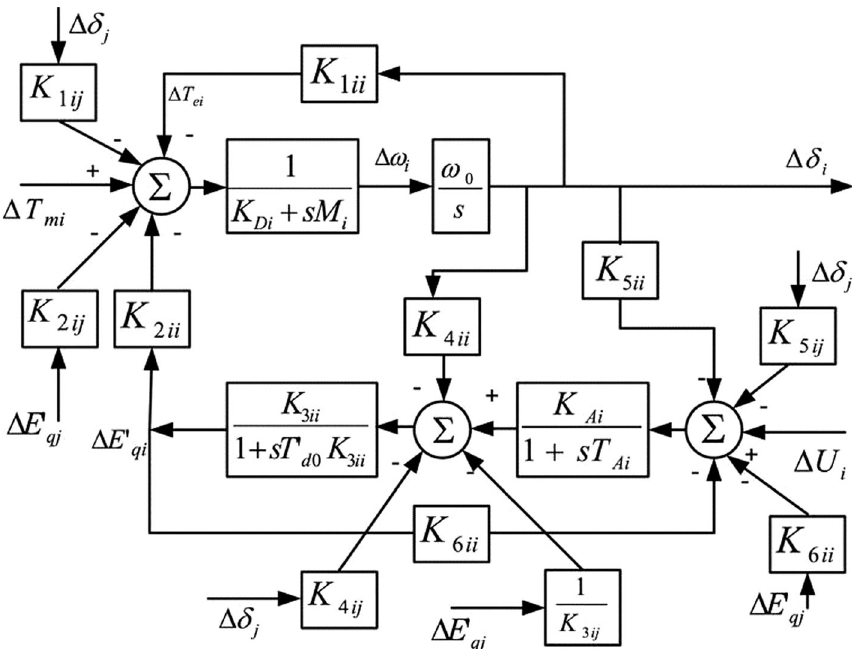
Fig. 4 Heffron - Philips model for multi-machine system